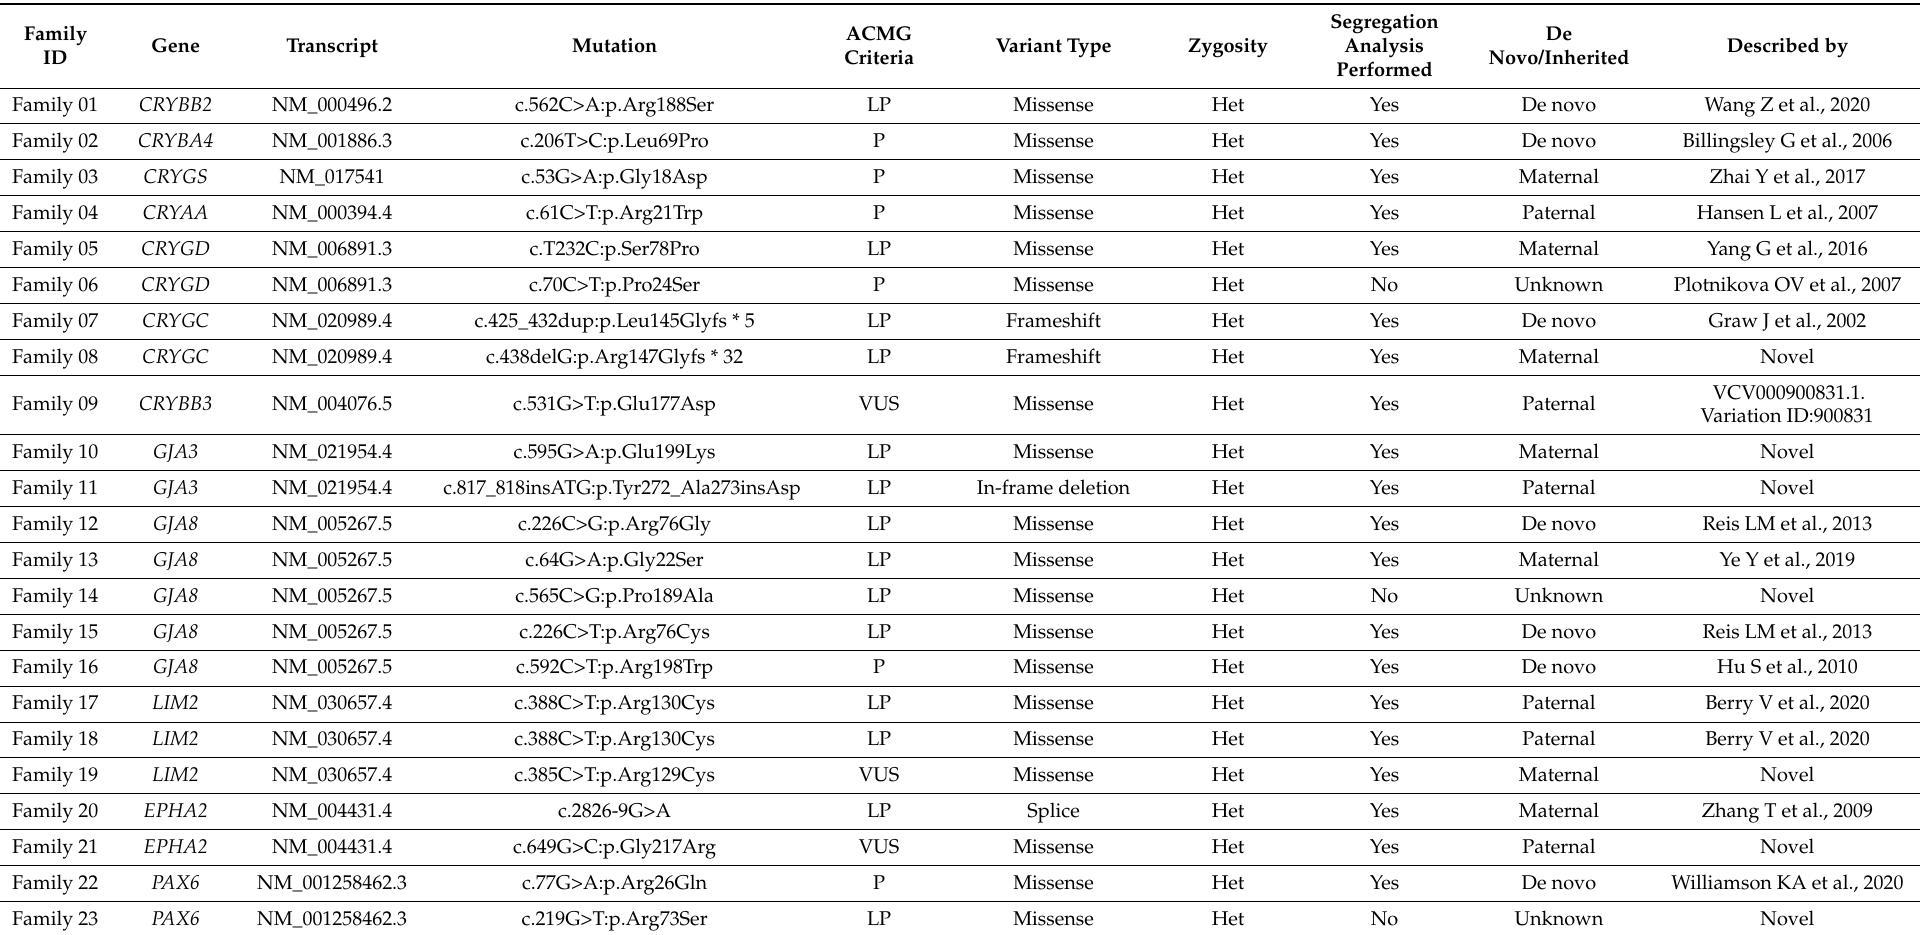
Table 2. Congenital cataracts NGS (next-generation sequencing) results. Het (heterozygosity). ACMG (American College of Medical Genetics and Genomics); VUS: uncertain significance variant, LP: likely pathogenic and P: